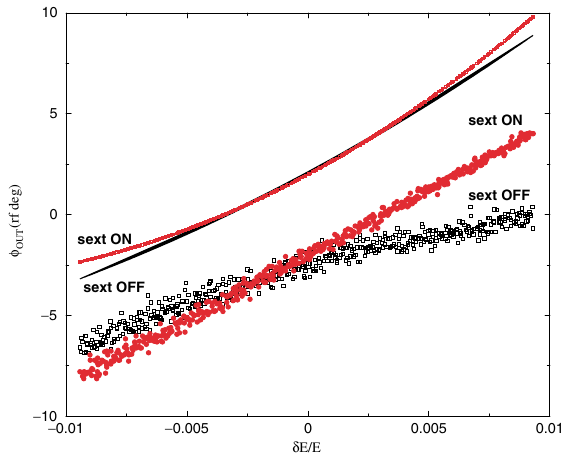
FIG. 12. (Color) Effect of the sextupole of arc 2 on the momentum compaction transfer map measured with the etector C3.